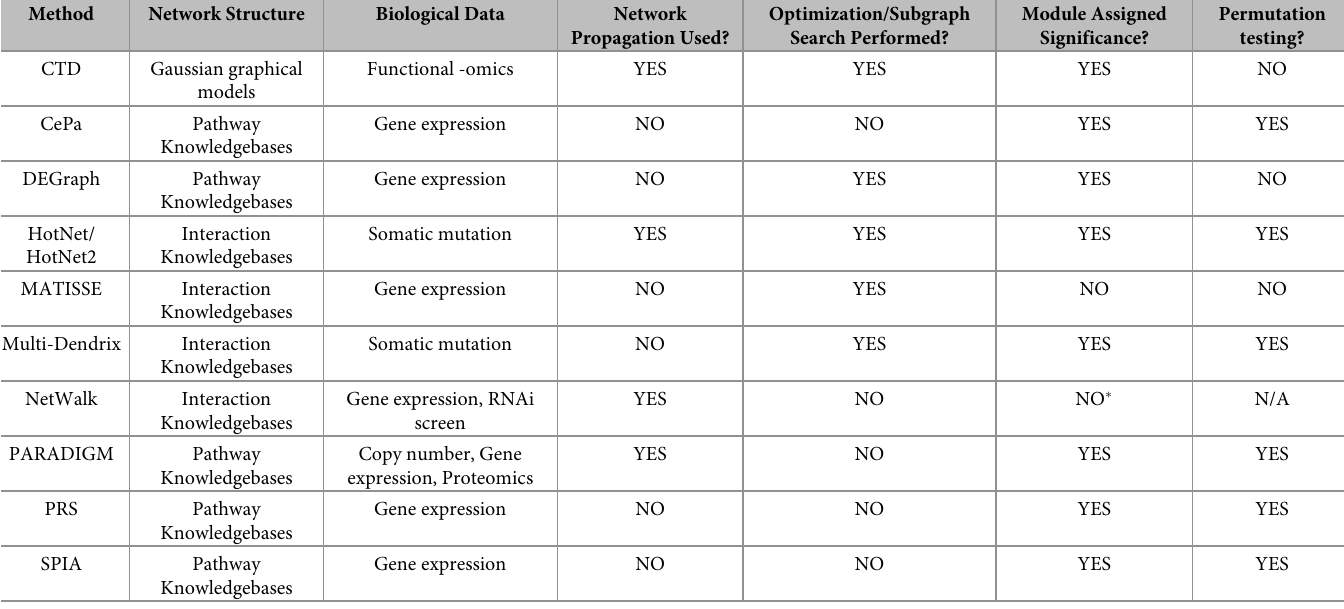
Table 4. Comparison of active module detection methods with